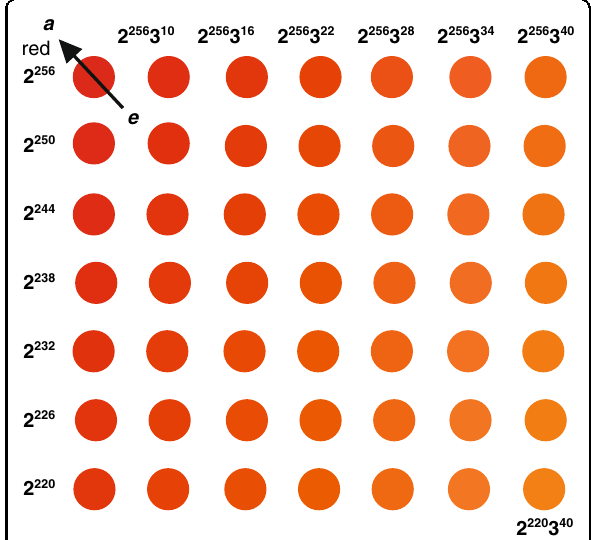
Fig. 4 Zoom-in area in the compressed C 235 wheel. Color a ð Þ